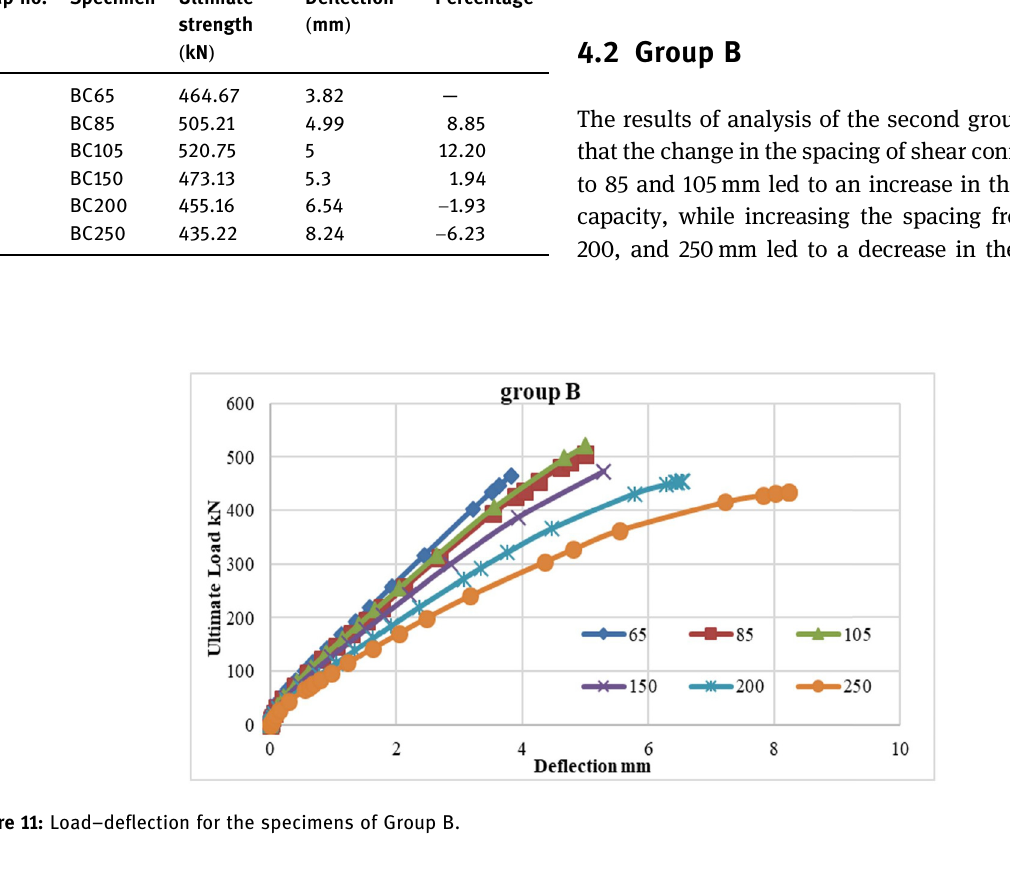
Table 3: Ultimate strength and de fl ection of midspan of Group B Group no. Specimen Ultimate